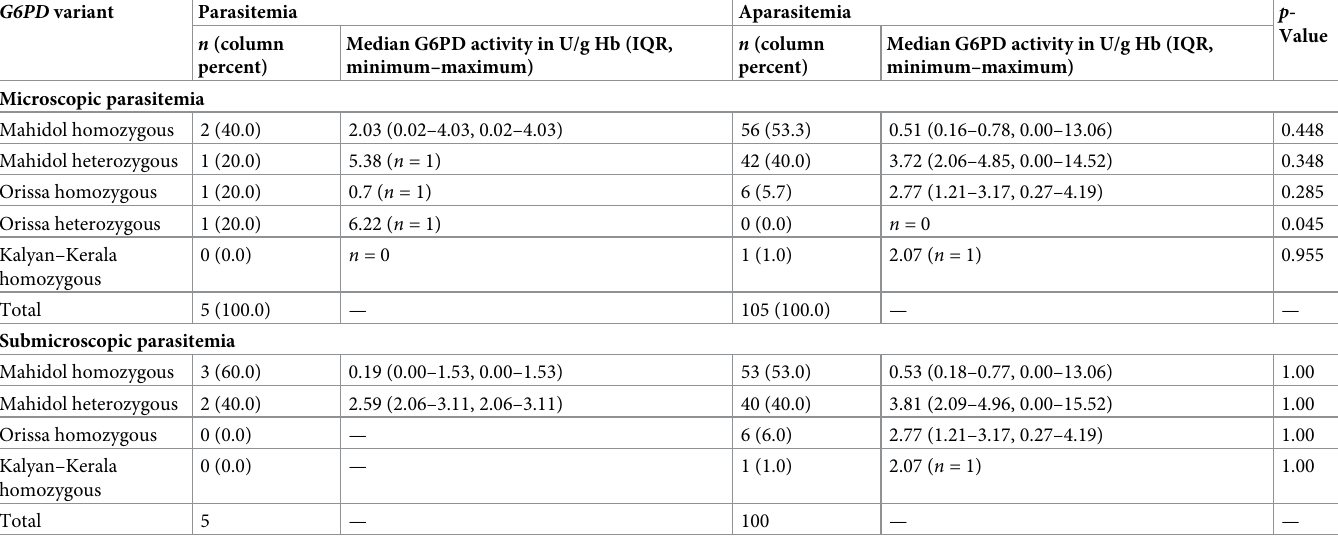
Table 4. G6PD variants and corresponding G6PD activity in participants of the clinical trial and cross-sectional survey. G6PD